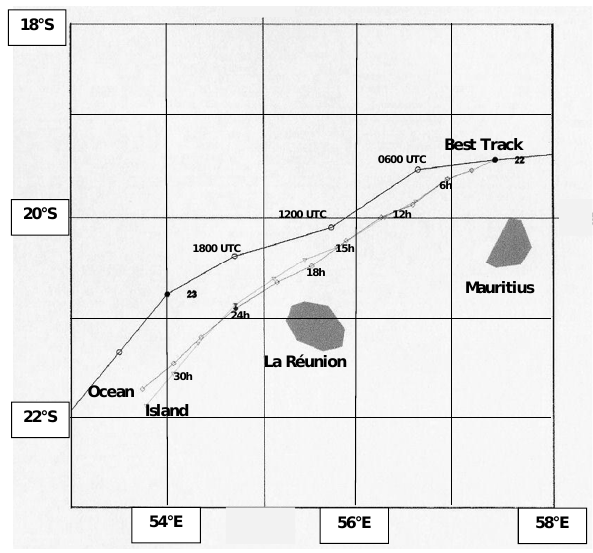
Fig. 4. Best track of tropical cyclone Dina (circles) and simulated tracks from the two numerical experiments (“ Island ” experiment: triangles, “ Ocean ” experiment: squares) from 00:00UTC on 22 Jan- uary